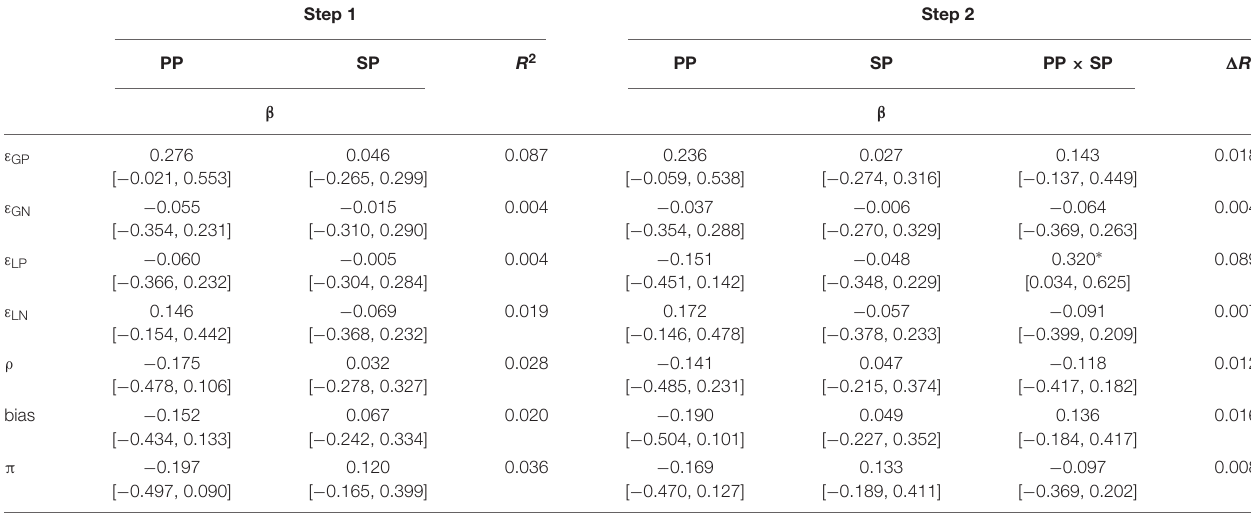
TABLE 3 | Results of hierarchical regression analyses for each learning parameter predicted by primary and secondary psychopathy scores. Step 1